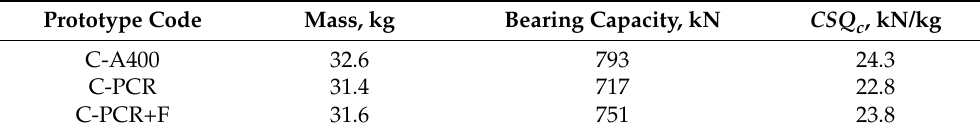
Table 10. The results of determining the structural characteristics of the sample columns.